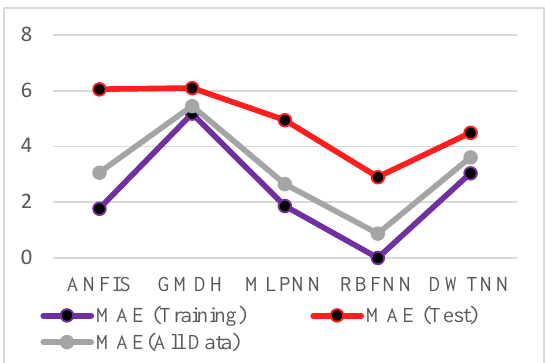
Fig. 18. MAE values for training and test set.